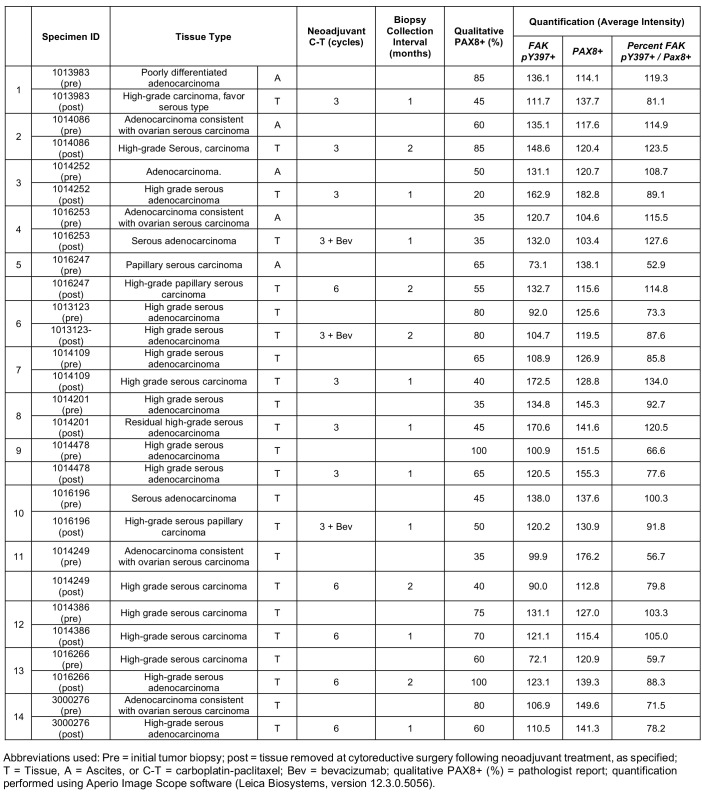
Patient tumor samples pre- and post-neoadjuvant chemotherapy, qualitative IHC score, and summary of quantitative image analyses.